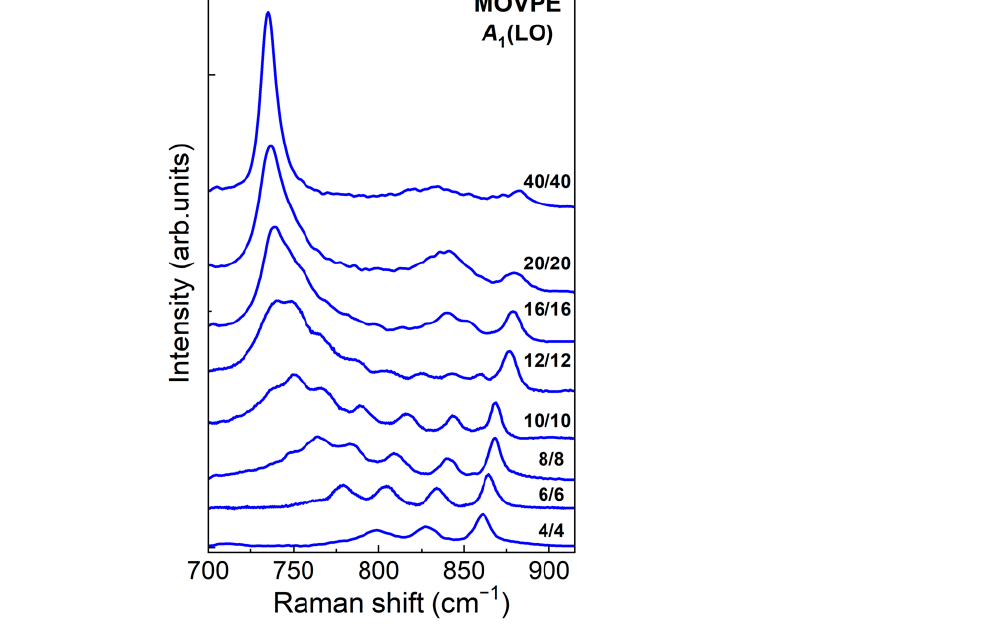
m /(AlN) m SLs with different